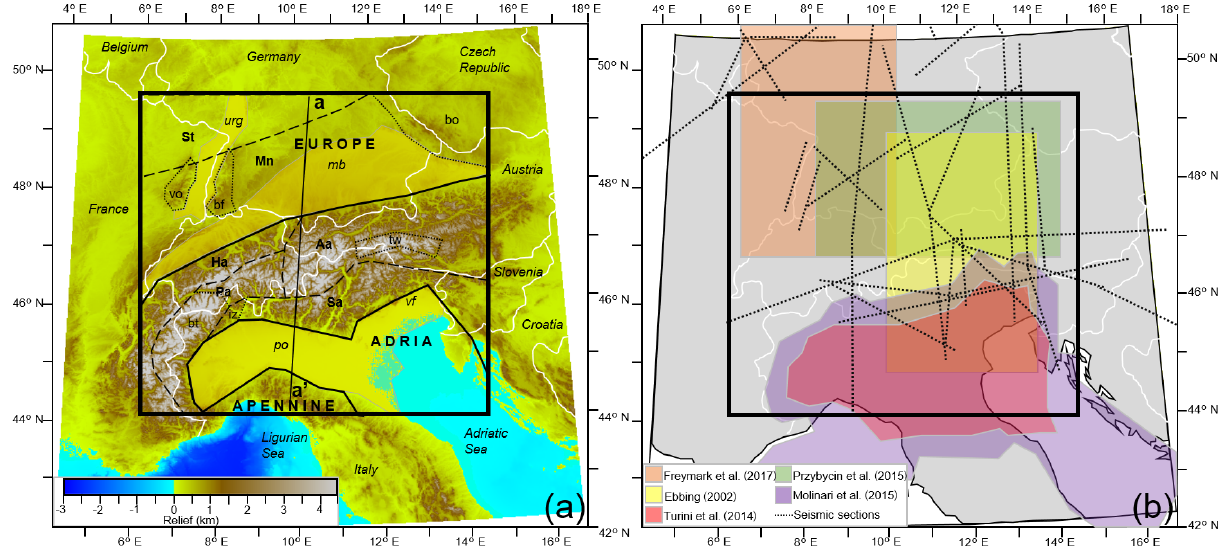
Figure 1. (a) Topography and bathymetry from Etopo 1 (Amante and Eakins, 2009) shown across the Alpine region with the key tectonic features overlaid. Study area is indicated with a black box. The line a–a’ represents the cross section in Fig. 3. Solid black lines demark the boundaries of the non-deformed European and Adriatic plates; the location of the Apennine plate is also marked. Dashed black lines indicate different geological domains (St – Saxothuringian Zone; Mn – Moldanubian Zone; Aa – Austro-Alpine unit; Ha – Helvetic Alps; Pa – Penninic Alps; Sa – Southern Alps). Dotted black lines indicate the extent of other tectonic features within these domains (bo – Bohemian Massif; vo – Vosges Massif; bf – Black Forest Massif; tw – Tauern Window; bt – Briançonnais Terrane; iz – Ivrea Zone). Yellow areas bound by a solid grey line indicate the extent of sedimentary basins (urg – Upper Rhine Graben; mb – Molasse Basin; po – Po Basin). (b) Input data source extents: Upper Rhine Graben gravity-constrained model (Freymark et al., 2017); Molasse Basin gravity-constrained model (Przybycin et al., 2015); TRANSALP gravity-constrained model (Ebbing, 2002); Po Basin seismically constrained models (Turini et al., 2014; Molinari et al., 2015); and seismic sections (IESG, 1978; IESG and ETH Zuerich, 1981; Strößenreuther, 1982; Mechie et al.,